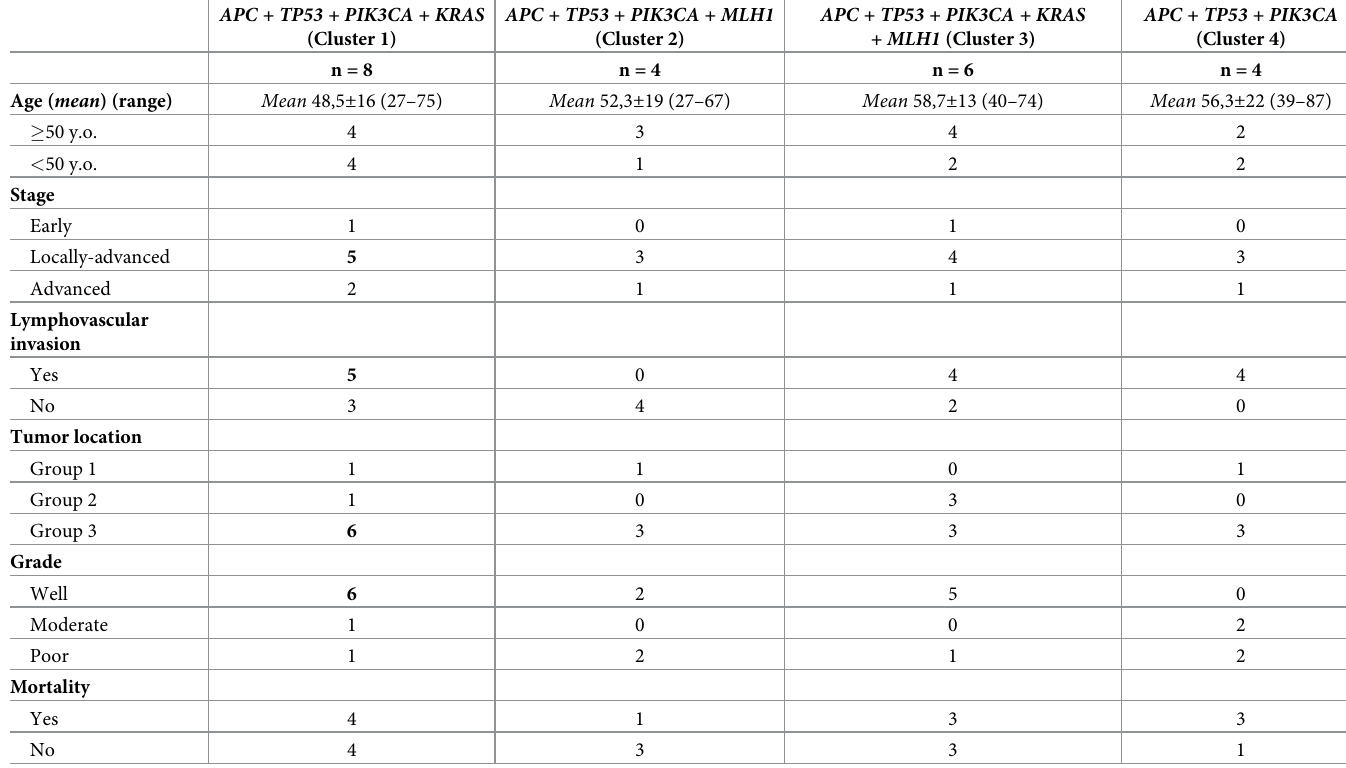
Table 10. Clinical manifestation of each combination of co-occurring